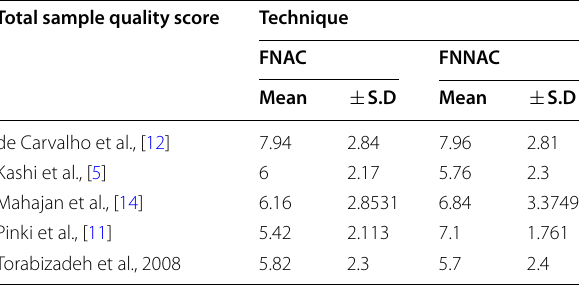
Table 13 Comparison between different studies regarding the total sample quality score using FNAC vs FNNAC [10] Total sample quality score